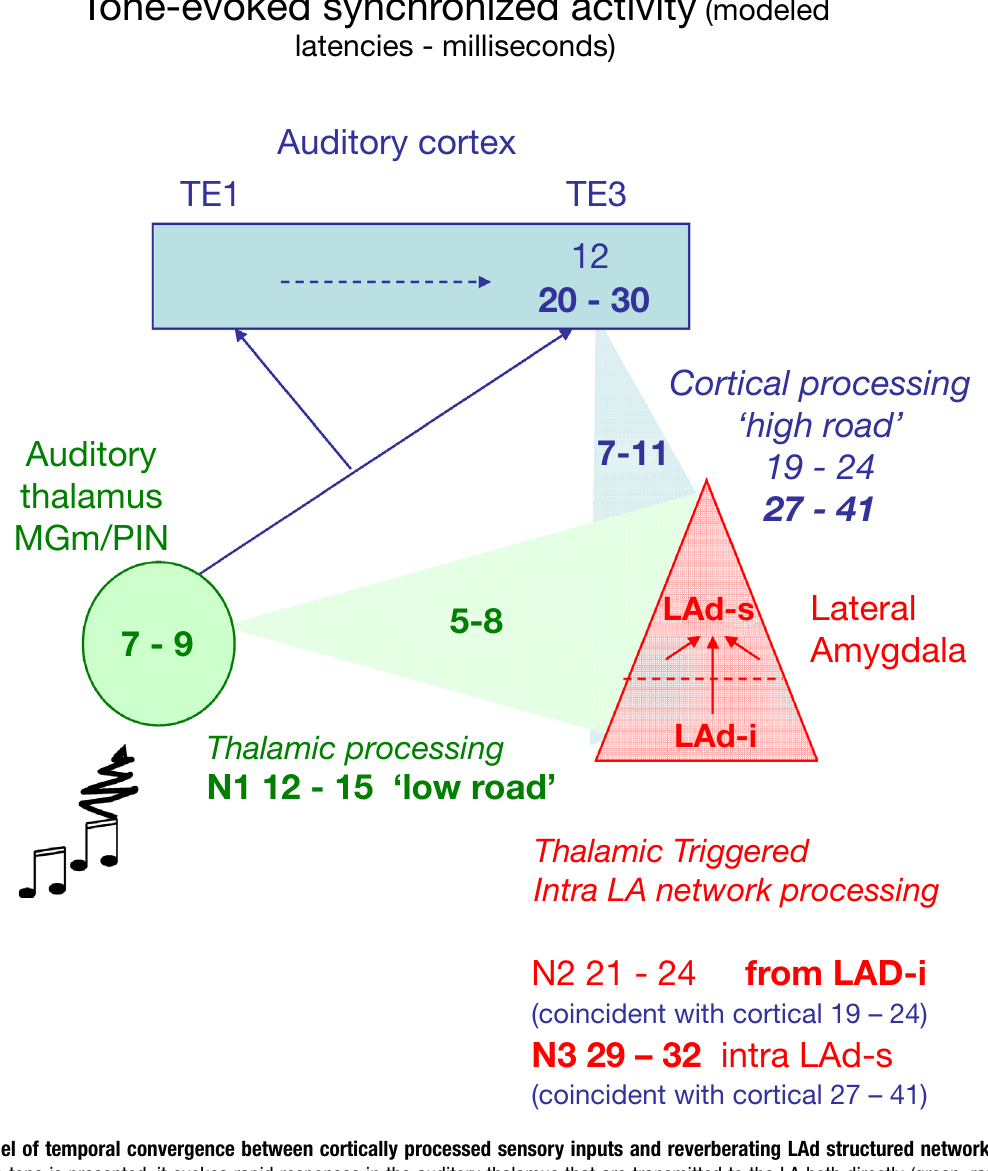
Figure 11 | Model of temporal convergence between cortically processed sensory inputs and reverberating LAd structured network activity. When a stimulus like a tone is presented, it evokes rapid responses in the auditory thalamus that are transmitted to the LA both directly (green, range of latencies as reported in the literature), and indirectly via auditory primary (TE1) and associative (TE3) cortex (blue, ranges of latencies from the literature). Both routes converge on the LA (red) with latencies that can be theoretically calculated taking into account the known thalamo-amygdala (5–8 ms, in green, producing N1) and cortico-amygdala (7–11 ms, in blue) latencies. From the TLPs observed in the present study in vivo , we can infer the latencies of the fi rst TLPs resulting from intra-LAd recurrent network processing (in red). This shows that a temporal coincidence may occur between synaptic potentials resulting from LAd recur- rent network processing (N2, N3, red) and cortically processed sensory signals through the cortical network (19–24 ms for the earliest, 27–41 ms at its peak, in